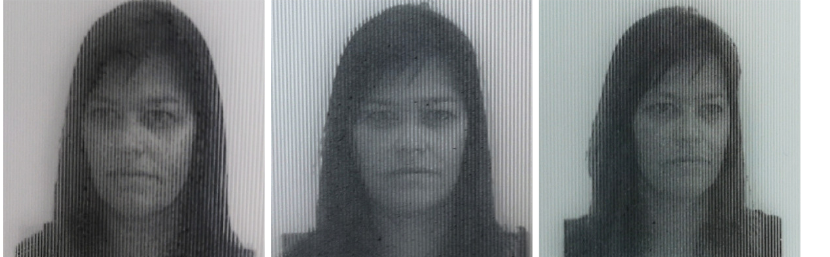
Figure 23. Example head views generated for printing.